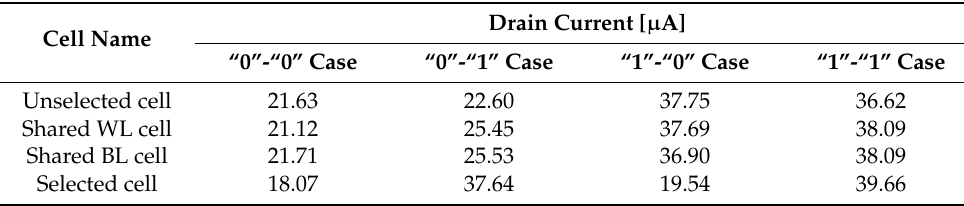
Table 5. Read current value at each location at 10 ns after application of the read voltage in the four